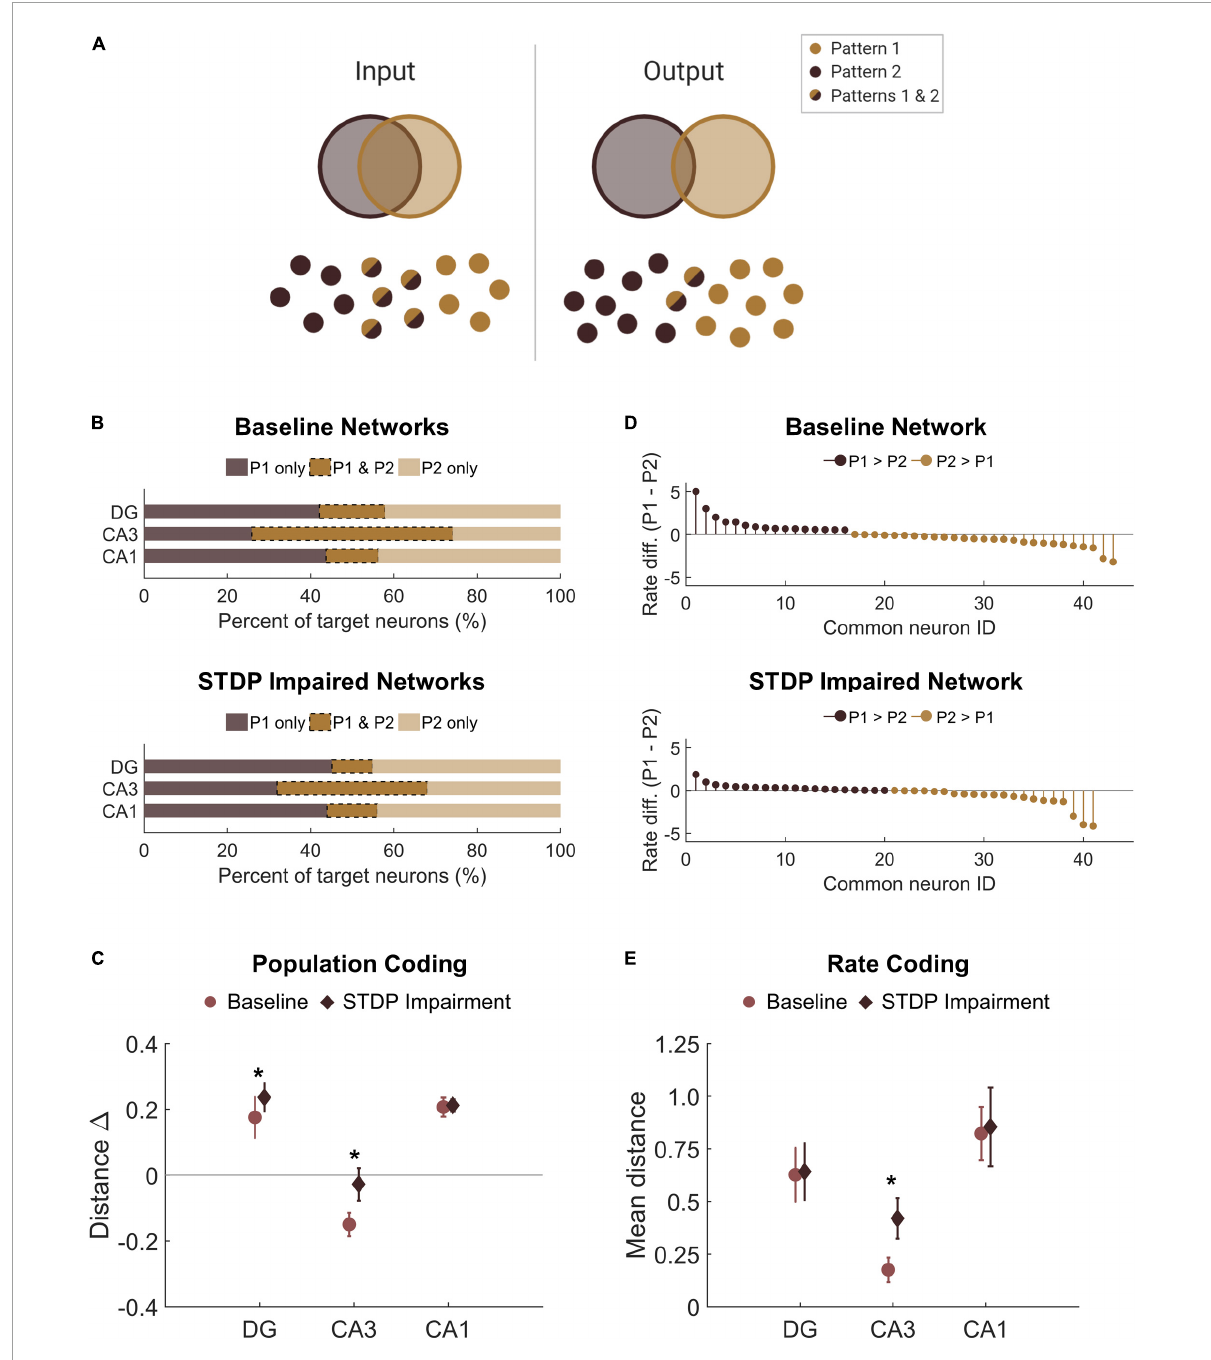
FIGURE7 There is no pattern separation deficit in circuits with STDP impairment. (A) Pattern separation occurs when the output patterns differ more than the input patterns do. In this study, we stimulated two patterns with 50% overlap in the population of input neurons. (B) For each region, the output populations consisted of 200 target neurons for each pattern. The percent overlap in baseline networks was below 20% for the DG and CA1. Similar to baseline networks, STDP impaired networks had low percentage overlap in the DG and CA1 with higher overlap in area CA3. (C) The difference between the Hamming distance of the input population and the output population measures pattern separation where a higher value indicates greater pattern separation. With STDP impairment, the distance between output populations was greater in the DG and CA3 than at baseline (paired Student’s t -test, p < 0.02 with significance determined by Bonferroni correction). (D) The rate difference between common neurons shows that common neurons responded preferentially to one pattern or the other. Common target neurons from the DG in one representative network are shown. P1 = pattern 1; P2 = pattern 2. (E) The distance between the rate response to pattern 1 vs. pattern 2 was computed as the Spearman distance. The rate distance for CA3 outputs was significantly different between baseline and STDP impaired networks (paired Student’s t -test, p < 1e-5). * p <